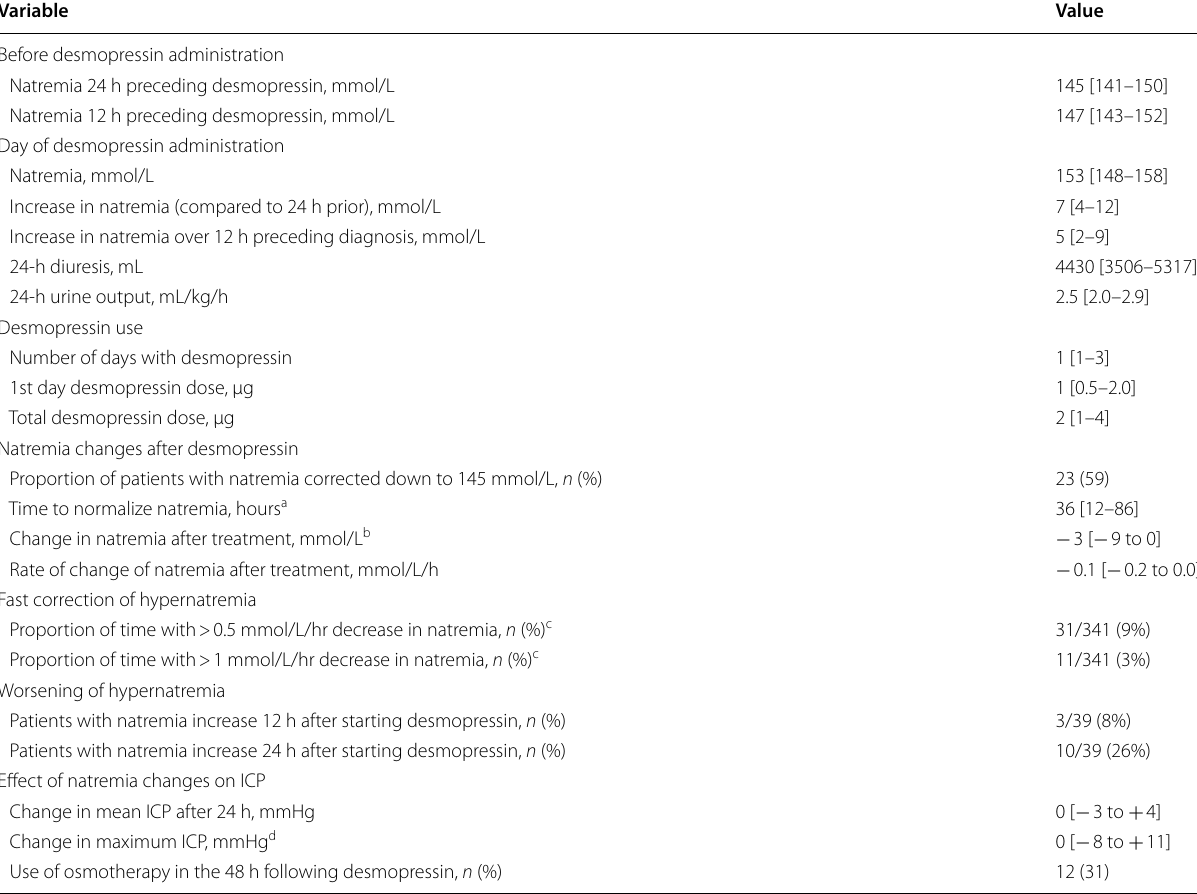
Table 2 Clinical and biochemical data before desmopressin administration, at the time of desmopressin administration and after starting